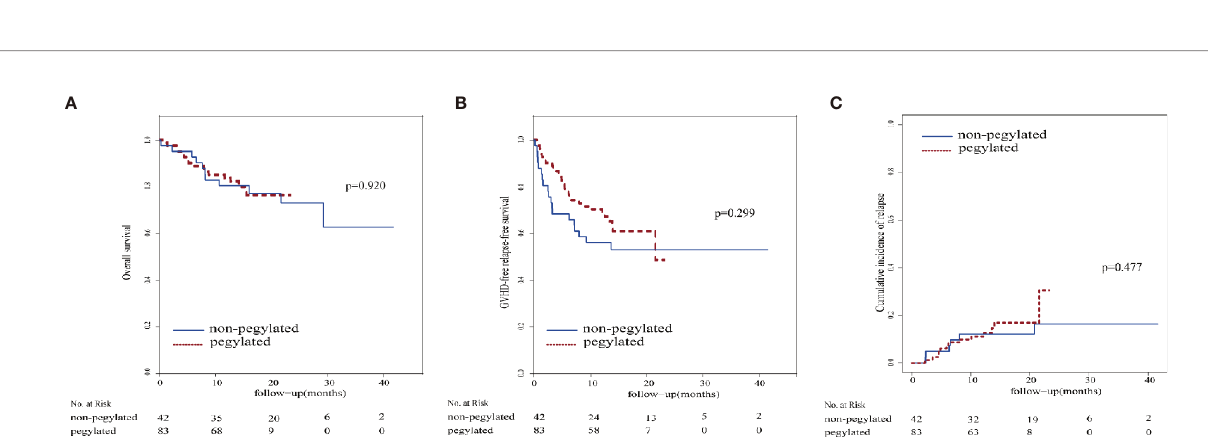
FIGURE 3 | Survival curve and relapse. (A) Overall survival, (B) Graft-versus-host disease-free relapse-free survival, (C) relapse cumulative